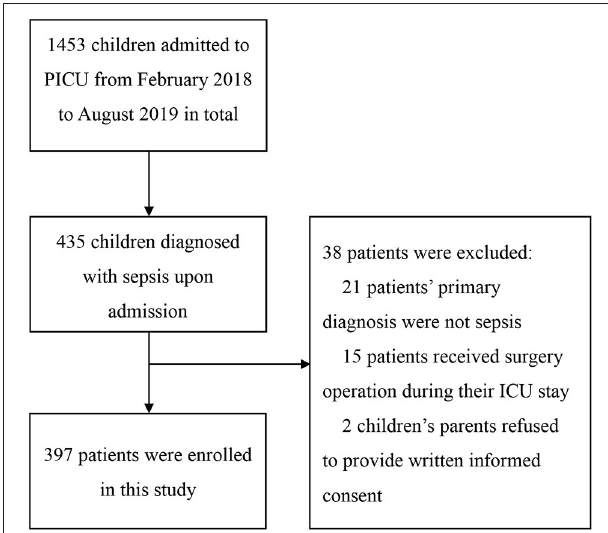
FIGURE 1 | Flow of patient enrollment.